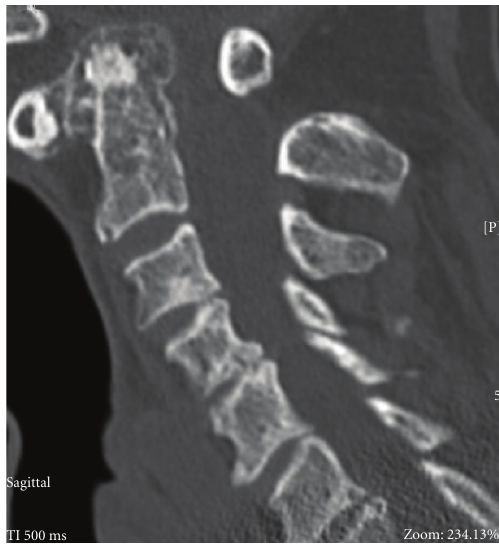
Figure 2: Sagittal CT scan reconstruction of a patient showing odontoid pannus reducing the diameter of the spinal canal at the level of the odontoid peg.